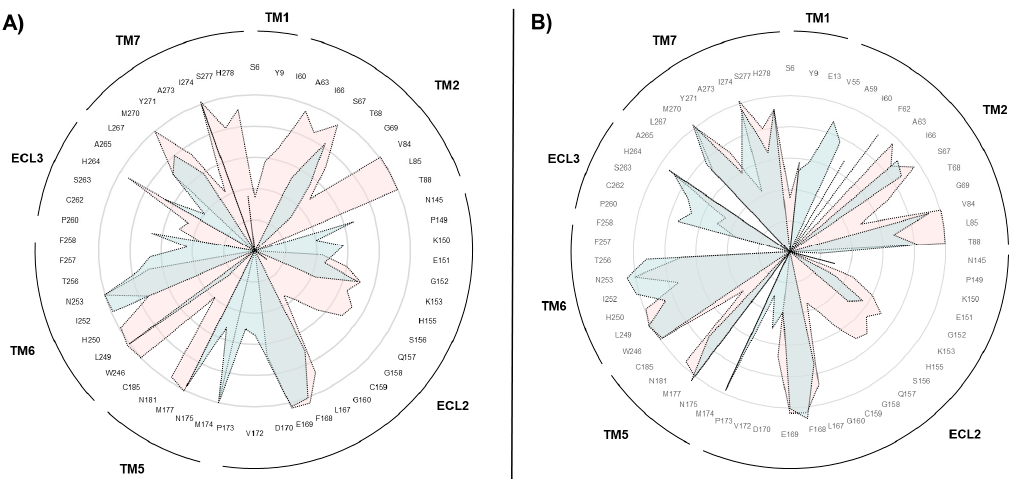
Figure 4. The adenosine experienced different patterns of interactions during SuMD dynamic docking on the intermediate-active and inactive A 2A AR conformations. The adenosine-A 2A AR contacts are plotted as polar diagrams of overlapping data. In panel ( A ) replicate 3a (productive binding to the intermediate-active receptor state, pink) and Replicate 5i (quasi-productive to the inactive receptor state, cyan) are compared. In panel ( B ), replicate 3a (productive binding to the intermediate-active receptor state, pink) is compared with replicate 10i (the only productive binding to the inactive receptor state, cyan).